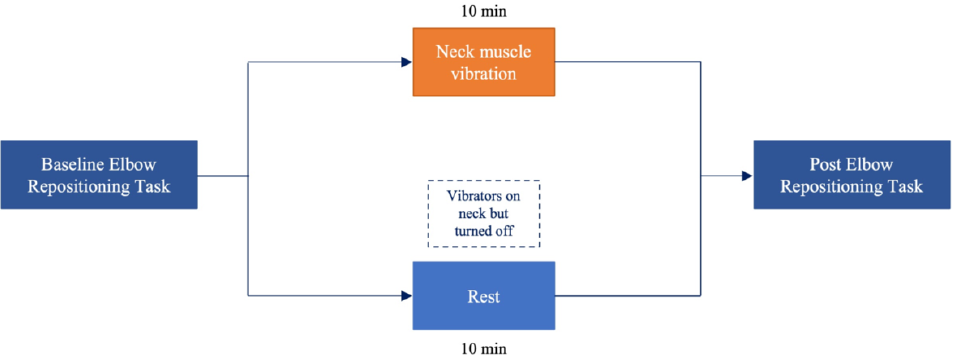
Figure 1. Flow of experimental procedures for both groups. For the rest condition, vibrators were placed on the neck but not turned on.